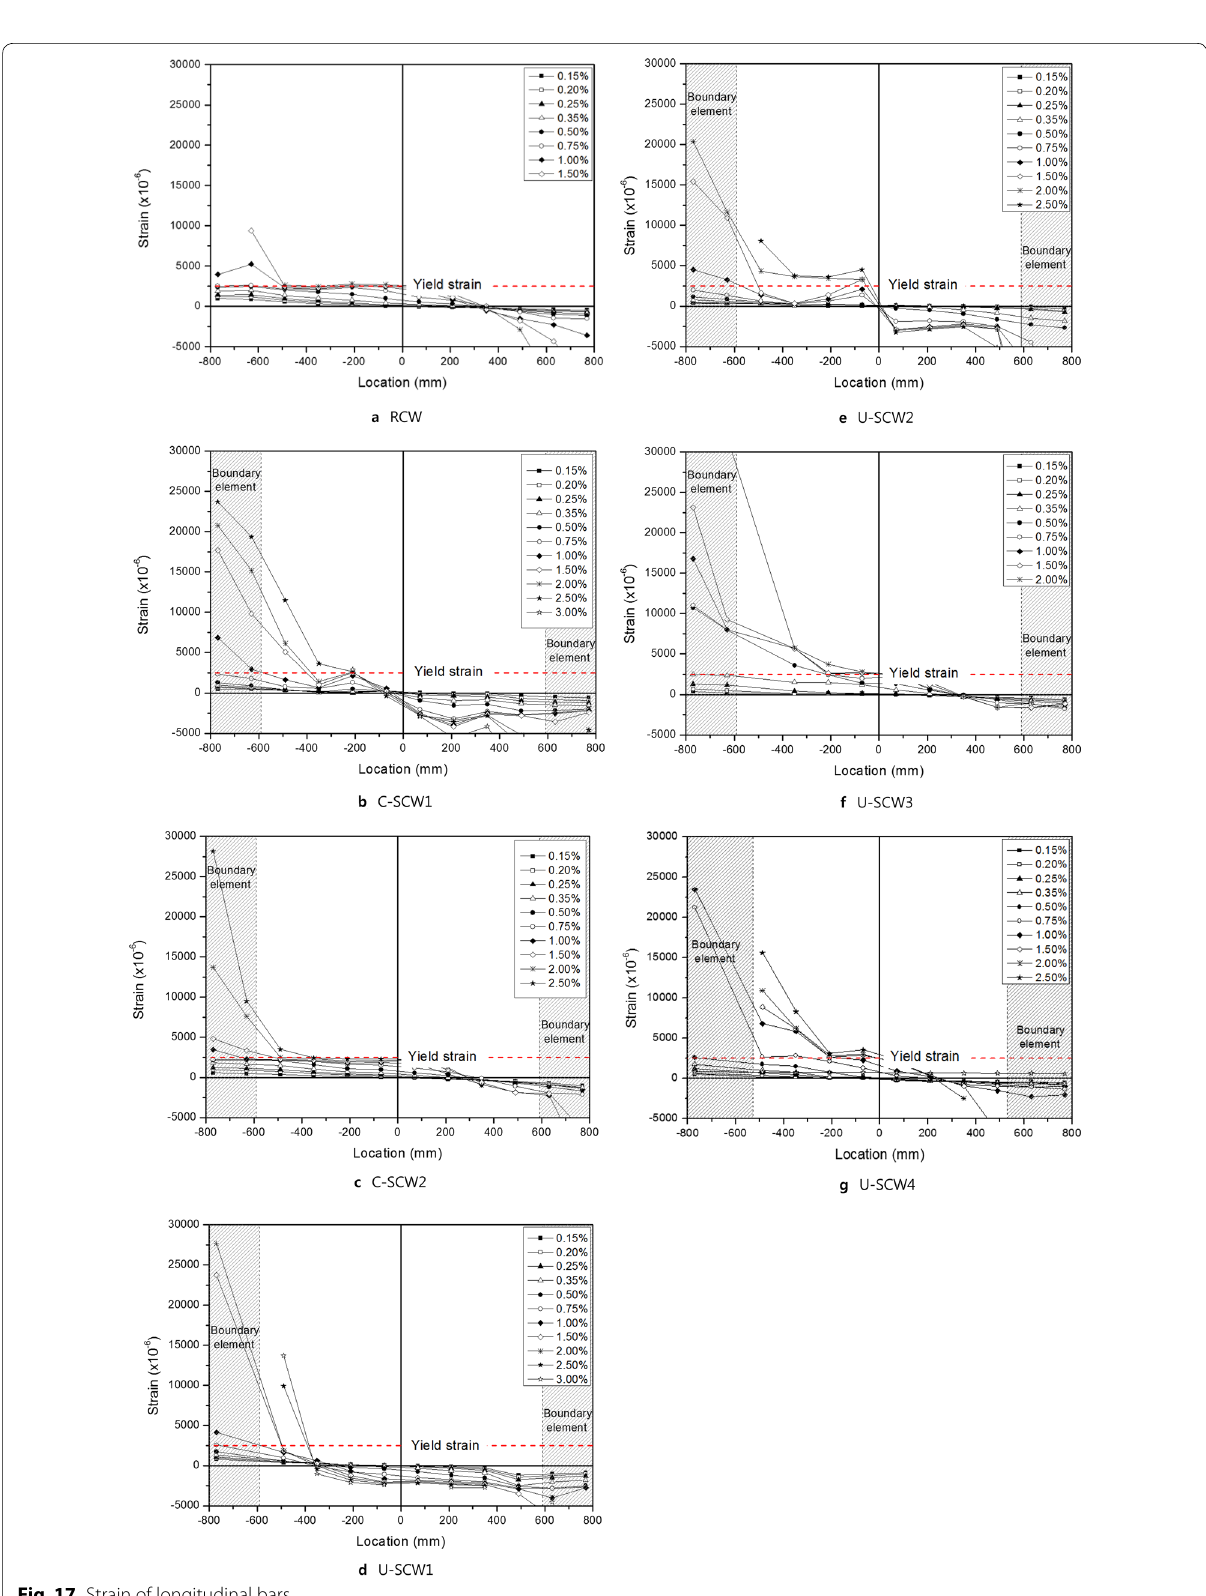
Fig. 17 Strain of longitudinal